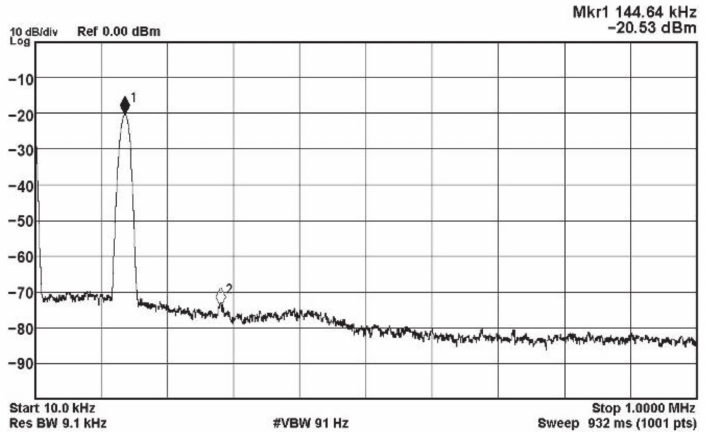
Figure 21. Frequency spectrum of the IBPF at the V o2 output terminal.